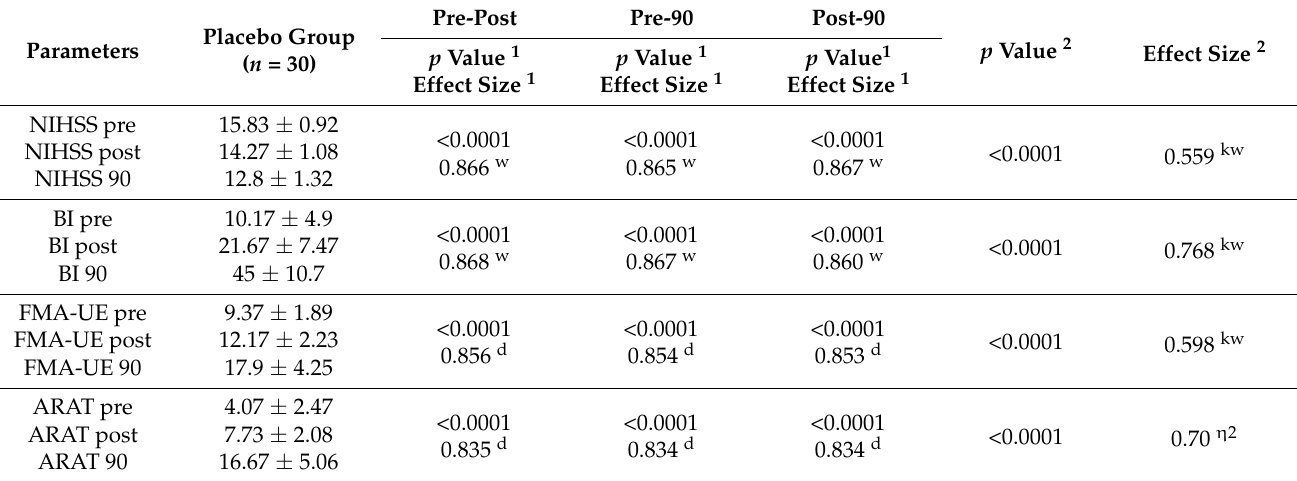
Table 4. The changes in outcome measures over time for NIHSS, BI, FMA-UE, and ARAT in the placebo group.